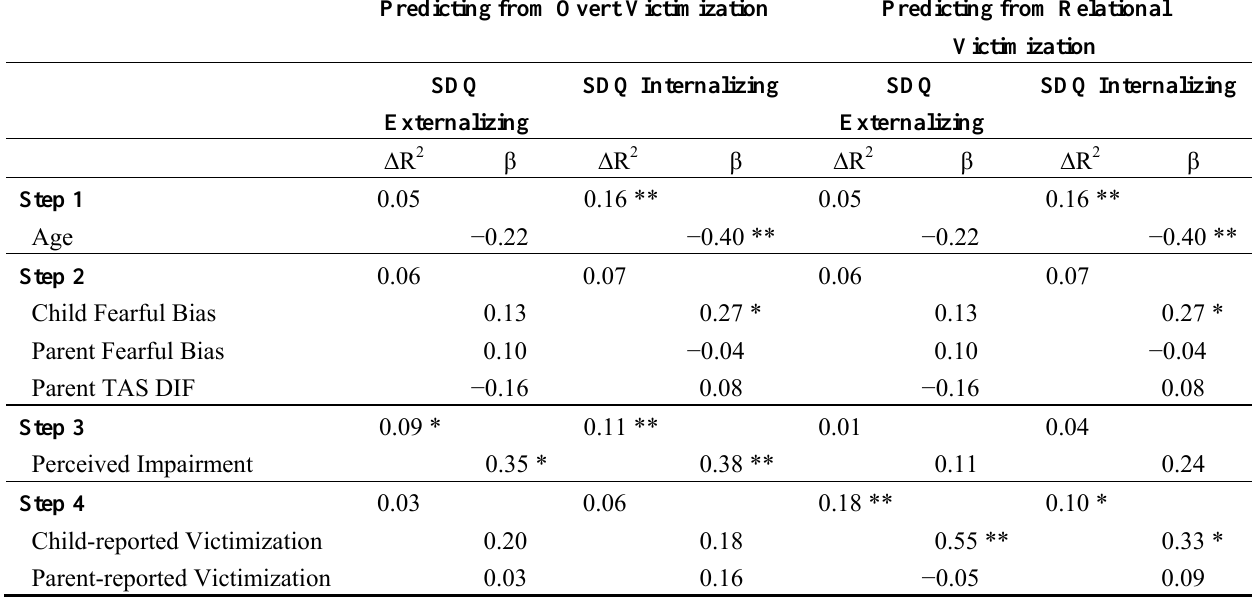
Table 4. Hierarchical Multiple Regression Analyses Predicting Strengths and Difficulties Questionnaire (SDQ) From Emotion Biases and Victimization.